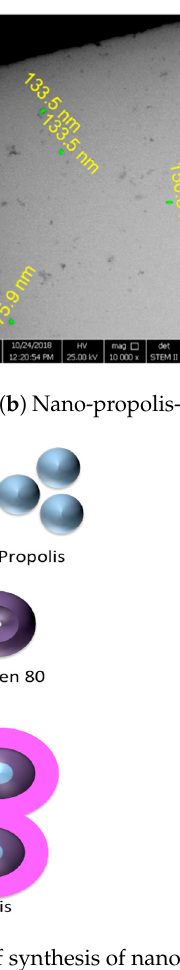
Figure 10. The schematic diagram of synthesis of nano-propolis.